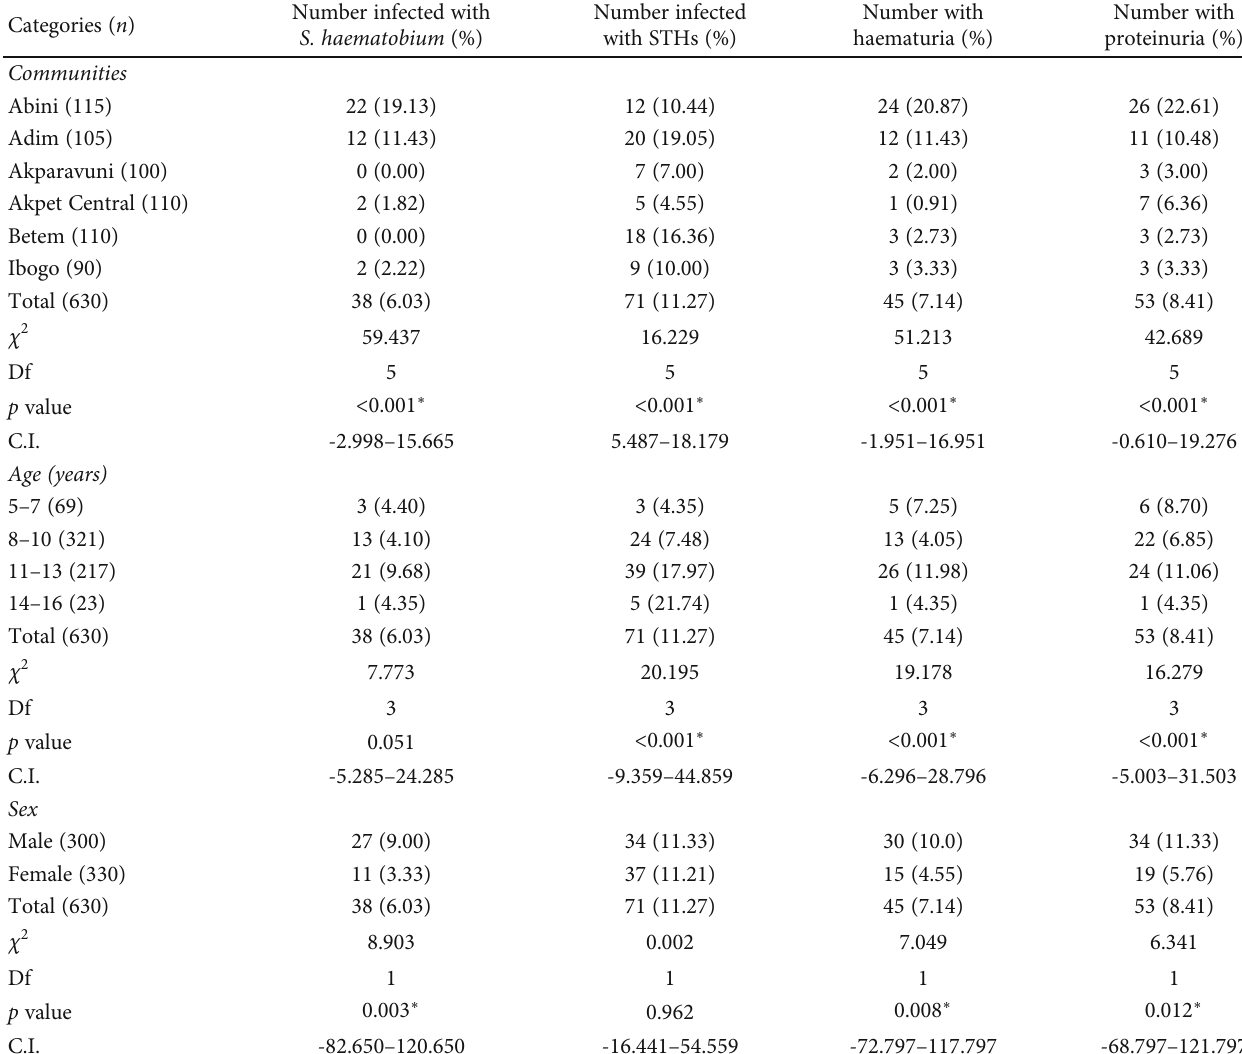
Table 2: Prevalence of S. haematobium , STHs, haematuria, and